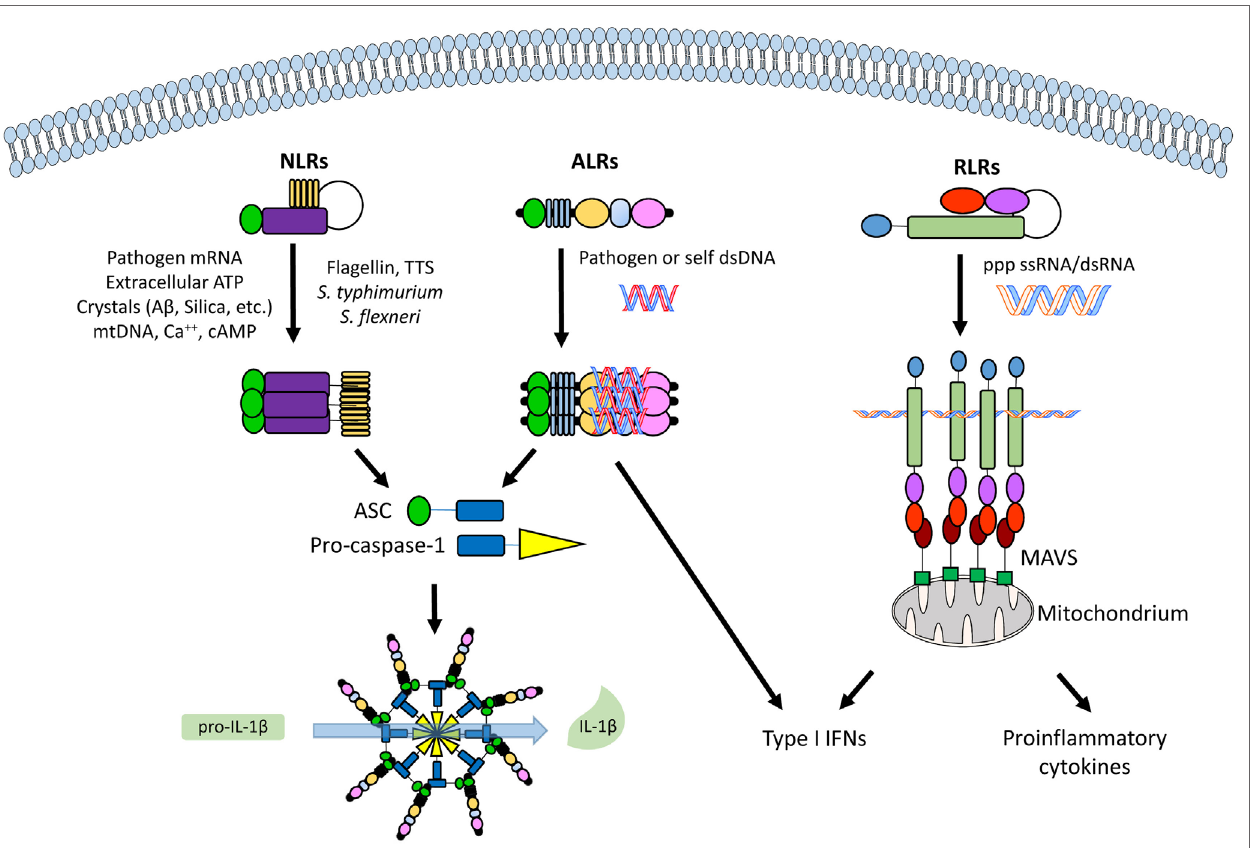
FigURe 2 | An overview of the different classes of cytoplasmic and nuclear pathogen recognition receptors (PRRs) and their involvement with inflammasome activation. From left to right, a nucleotide-binding oligomerization domain-like receptor (NLR, e.g., NLRP3), an absent in melanoma 2 (AIM2)-like receptor (ALR, e.g., IFI16), and a retinoic acid inducible gene I (RIG-I)-like receptor (RLR, e.g., RIG-I), with their commonest ligands. See text for details. Abbreviations: ASC, apoptosis-associated speck-like protein containing a caspase recruitment domain (CARD); MAVS, mitochondrial antiviral signaling